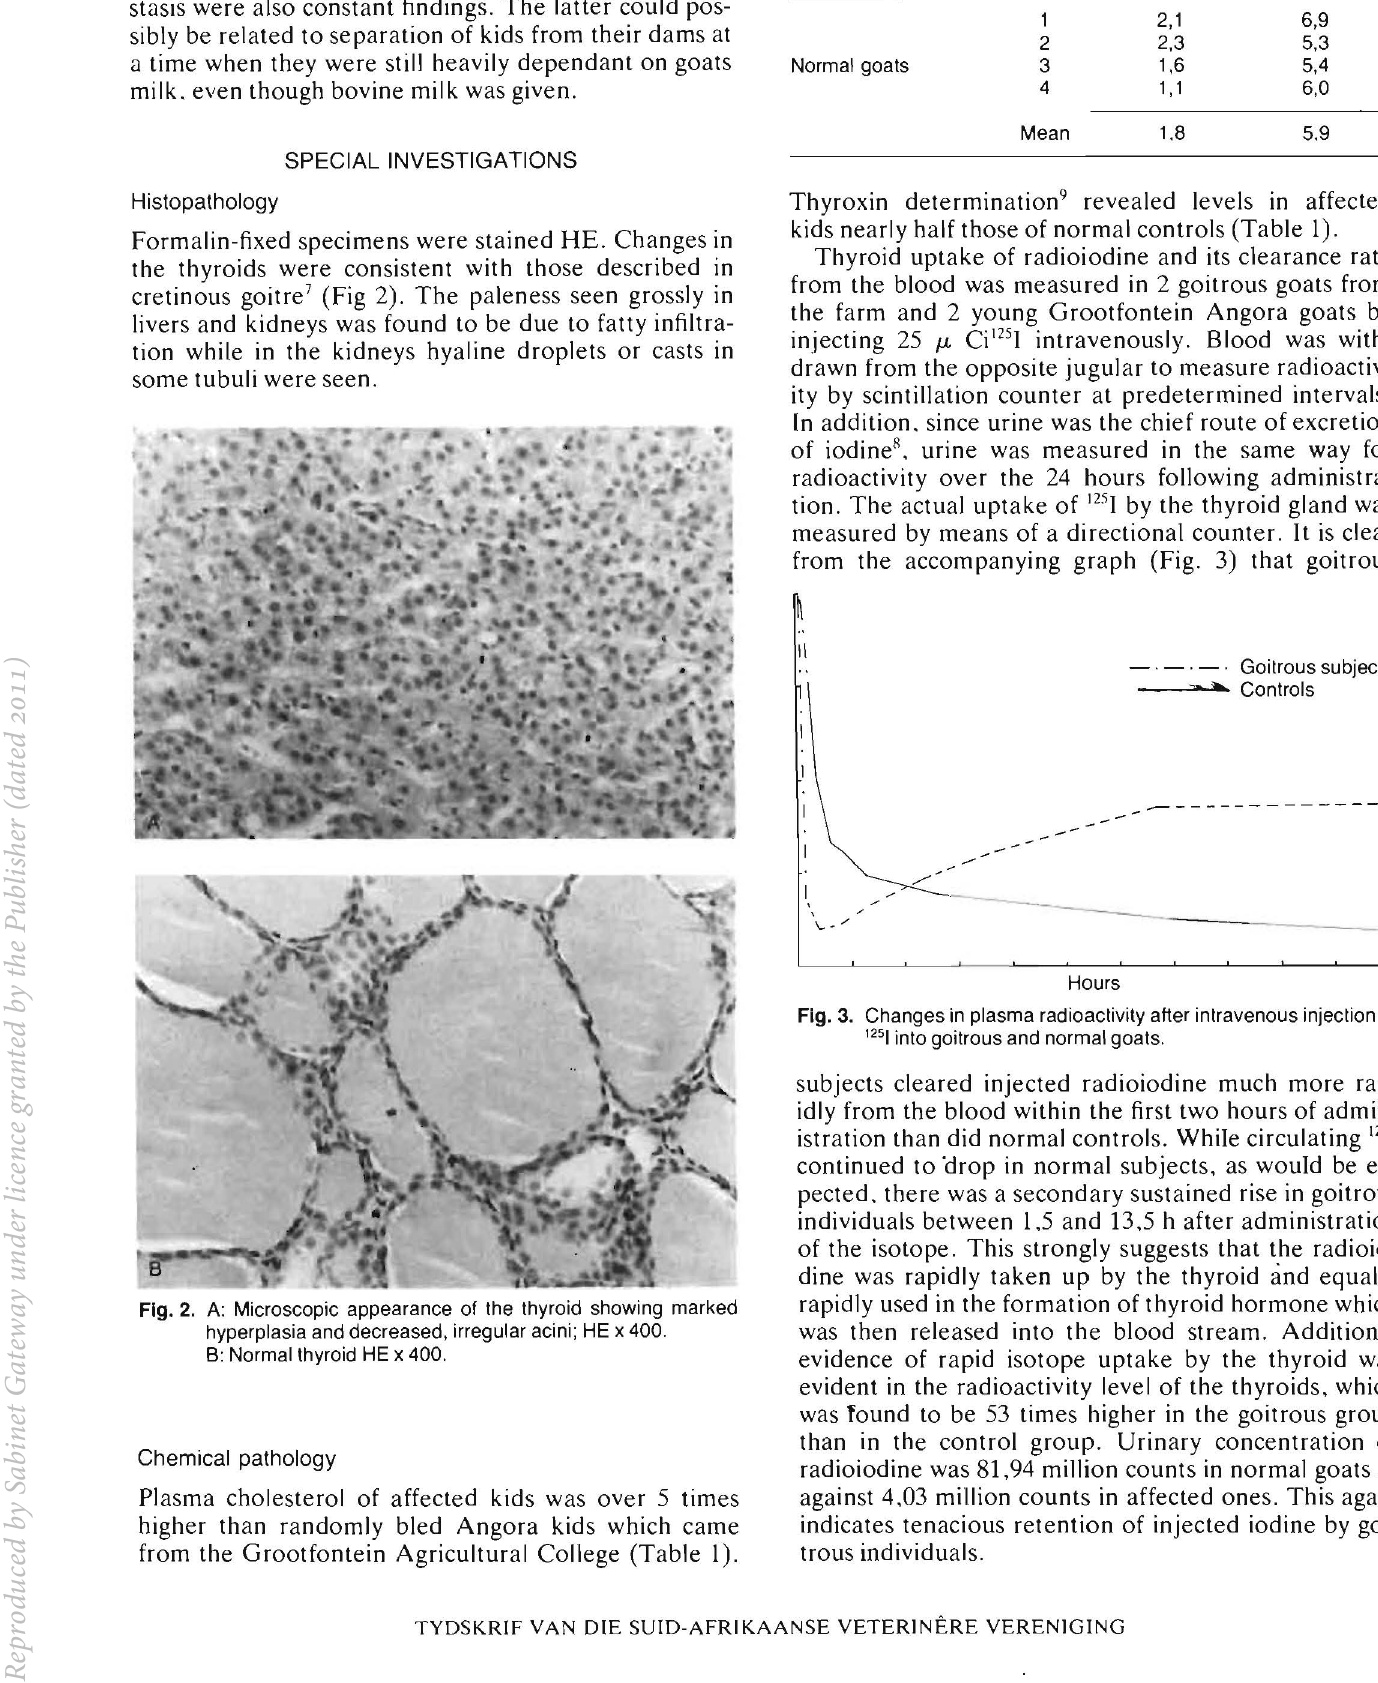
Fig. 3. Changes in plasma radioactivity after intravenous injection 0 125 1 into goitrous and normal goats. subjects cleared injected radioiodine much more rap idly from the blood within the first two hours of admin istration than did normal controls. While circulating